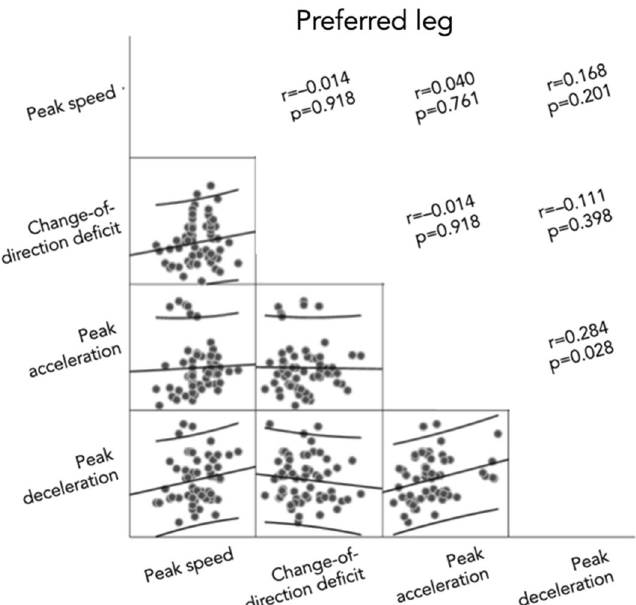
Figure 3. Correlation matrix between measures for preferred leg.